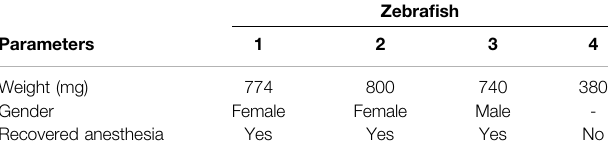
TABLE 1 | Identi fi cation of the zebra fi